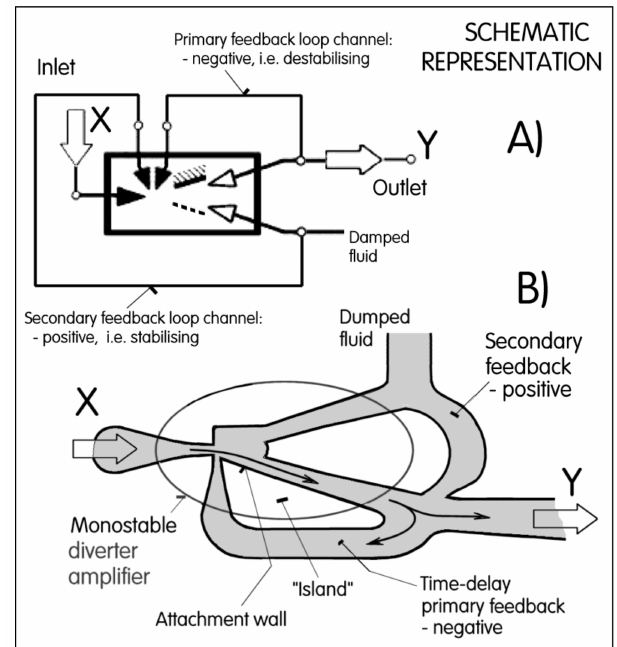
Figure 19. An example of pulse shaper with monostable amplifier and two mutually opposed time-delay feedback loops. ( A ) Schematic representation of the configuration with both positive and negative loops. ( B ) Planar pulse shaper cavity (of constant depth everywhere). Note the secondary feedback loop missing in Figure